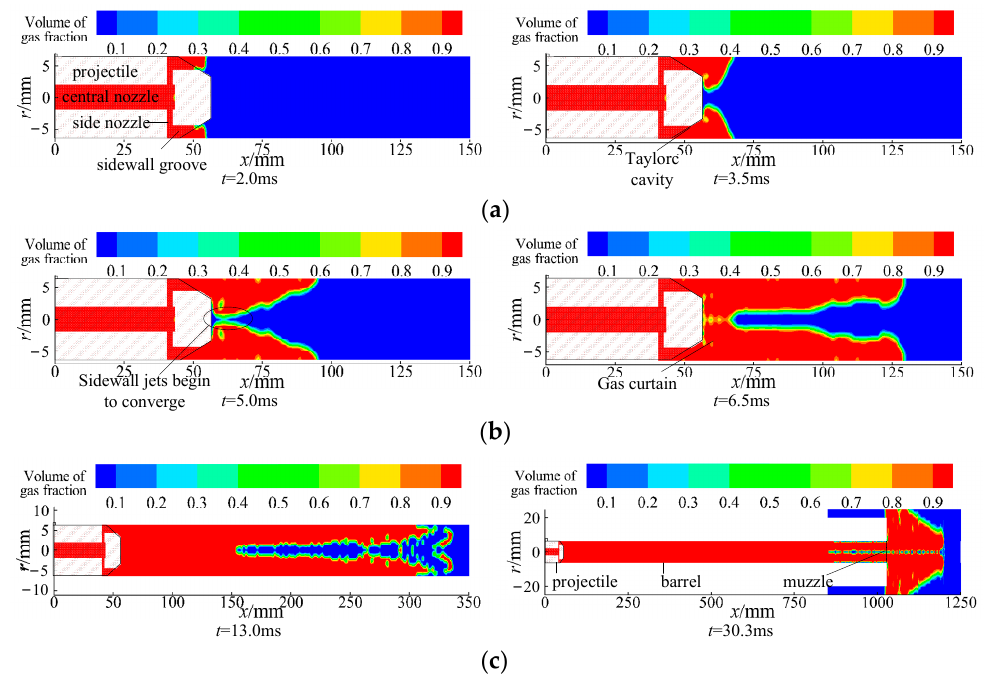
Figure 8. The gas-curtain evolution process (projectile C). ( a ) The first stage; ( b ) the second stage; ( c ) the third stage.